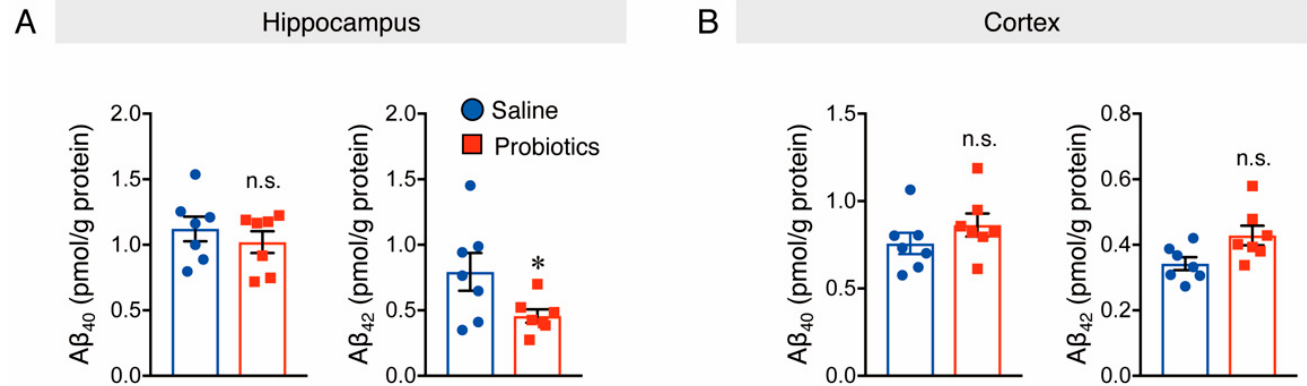
Figure 2. Oral administration of B. breve MCC1274 reduces soluble hippocampal A β 42 levels in WT mice. Soluble hippocampal A β 40 and A β 42 levels ( A ) and soluble cortical A β 40 and A β 42 levels ( B ) in WT mice were measured by Sandwich ELISA. A β levels were normalized to each protein concen- tration. Data are represented as the mean ± SD, n = 7 per group, n.s. no significant difference, * p < 0.05 compared with the saline group, data analyzed by Student’s t -test.